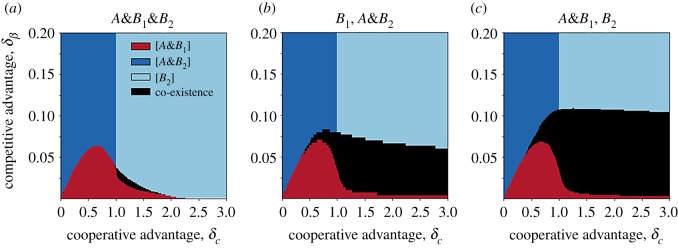
Equilibrium configurations for two interacting communities. Final outcome obtained by numerically integrating the equations when: (a) all strains start in the same community (together with A); (b) B1 and B2 start in separate communities, with A starting together with B2; (c) A starts along with B1, while B2 starts separately. Initial density of each pathogen/strain is 0.01. Here ε = 0.0002. Other parameters are as in figure 2a.